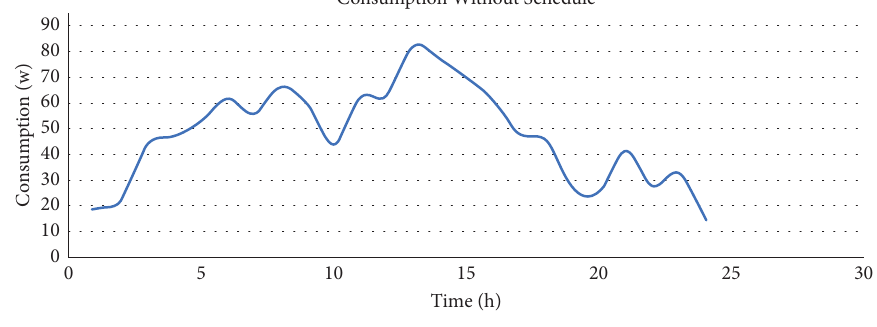
Figure 6: Consumption without